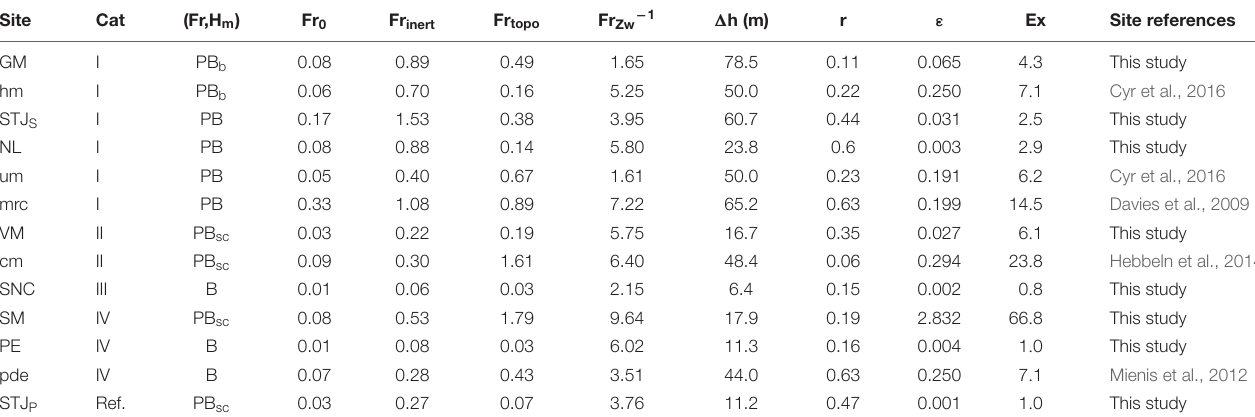
Shown are after the name of the sites and CWC categories the flow state (Fr,H m ), Froude number for one layer flow (Fr 0 ), the internal Froude number, Fr inert (Davies et al., 2009), topographical Froude number, Fr topo (Cyr et al., 2016), tidal excursion inverse Froude number, Fr Zw − 1 (Legg and Klymak, 2008; Mohn et al., 2014), vertical isopycnal displacement scale, (cid:49) h (in meters), the layer thickness ratio, r, non-hydrostatic parameter, ε , and excursion number, Ex. For details see Sections "Other Representations for Hydraulic Control" and "Data Analysis." GM, Galway Mound; hm, Haas CWC mound; STJ S , Stjernsund CWCs; NL, Nordleksa; um, unnamed smaller mound; mrc, Mingulay Reef complex; VM, Valentine Mounds; cm, Campeche CWC mound; SNC, St. Nazaire Canyon; SM, Sylvester Mound; PE, Pagés Escarpment; pde, Pen Duick Escarpment; STJ P , Stjernsund reference; PB b , mostly blocked flow with regularly partially blocked conditions; PB, partially blocked flow; PB sc , mostly subcritical flow with regularly partially blocked conditions; B, completely blocked